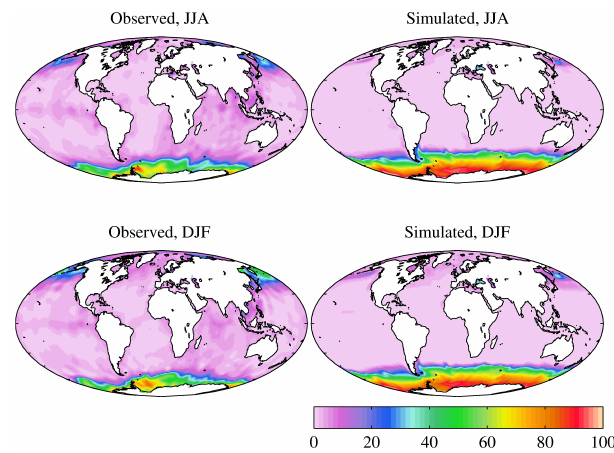
A. Yool et al.: A description of M EDUSA –2.0 23 Fig. 4. Observational (World Ocean Atlas, 2009; left ) and simulated ( right ) surface dissolved inorganic nitrogen for northern summer (June–July–August; top ) and northern winter (December–January–February; bottom ). Concentra- tions in mmol m − 3 .